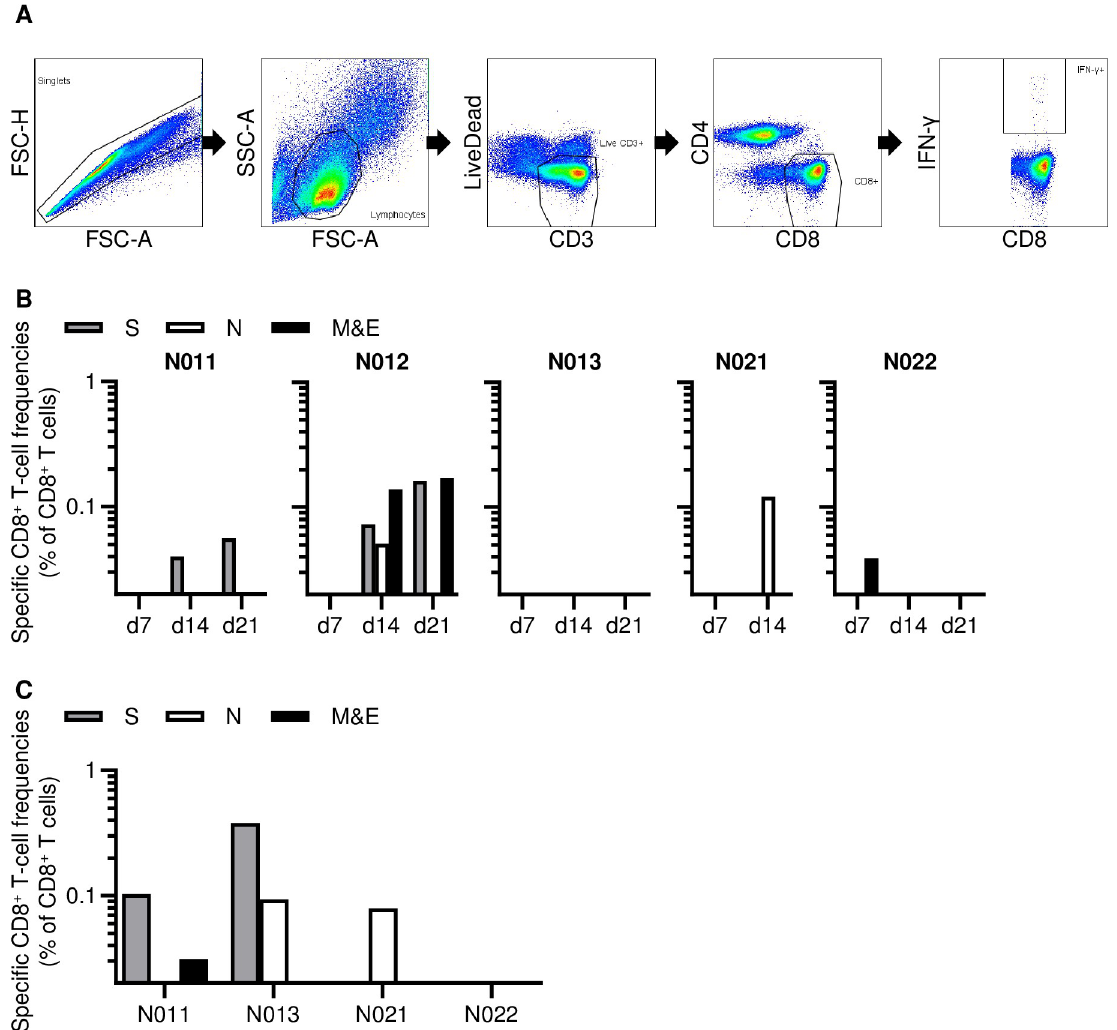
Fig 5. SARS-CoV-2-specific CD8 + T-cell responses. (A) Representative gating schema for detection of IFN- γ induction after stimulation with overlapping M&E peptide pools in macaque N012 on day 14 post-infection. (B) Frequencies of CD8 + T cells targeting S, N, and M&E in PBMCs on days 7, 14, and 21 post-infection in Group N animals infected with 10 6 (middle) or 10 5 (right) TCID 50 of SARS-CoV-2. (C) Frequencies of CD8 + T cells targeting S, N, and M & E in submandibular lymph nodes obtained at necropsy in macaques N011, N013, N021, and N022. Samples were unavailable for analysis in macaque